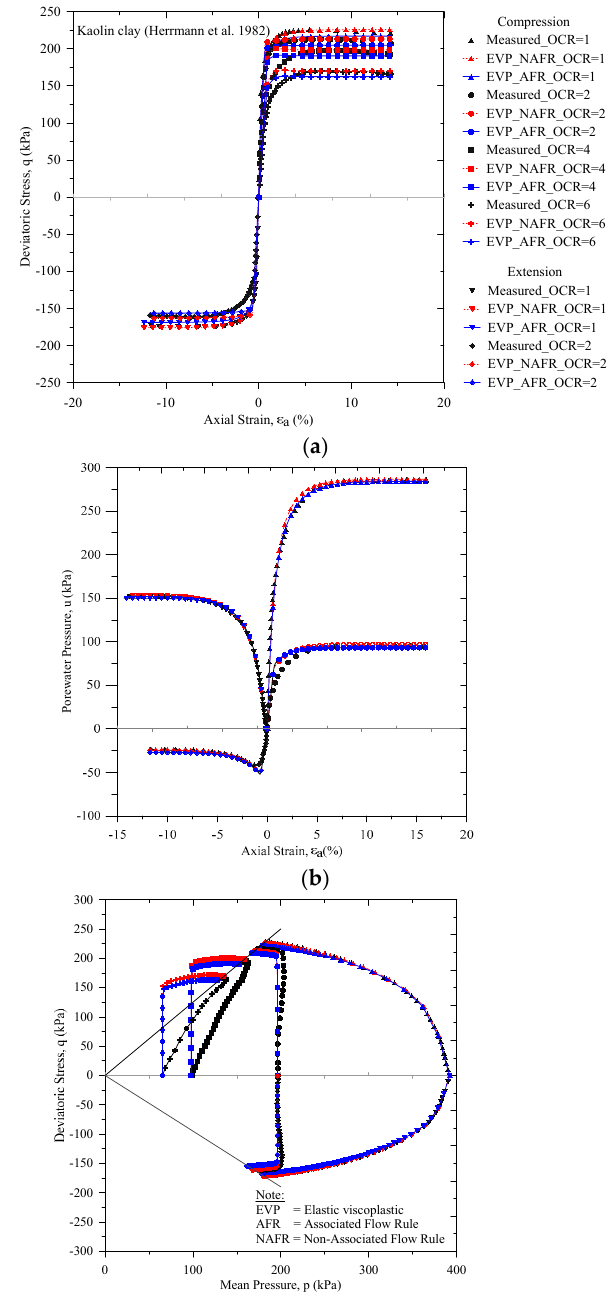
Figure 7. Comparison of the measured and the predicted consolidated undrained triaxial compression and the extension tests on the Kaolin clay: ( a ) the deviatoric stress vs. the axial strain; ( b ) the pore-water pressure vs. the axial strain; and ( c ) the stress path.